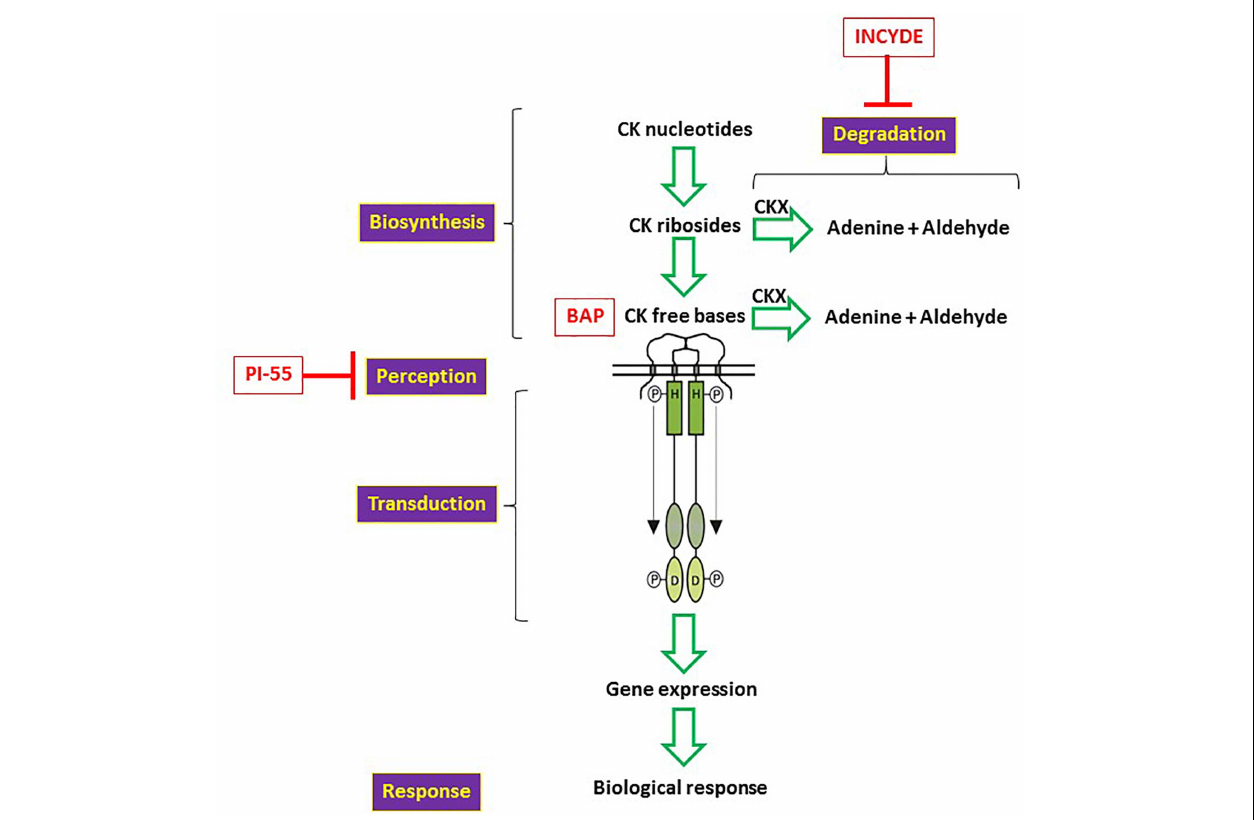
FIGURE 1 | Schematic representation of CK homeostasis in a plant cell. CK nucleotides are the precursors of the CK ribosides and CK free bases (e.g., BAP). Both types of CKs are substrates of the enzyme CK oxidase (CKX) and they will be degraded upon enzymatic activity. When active free bases are perceived by